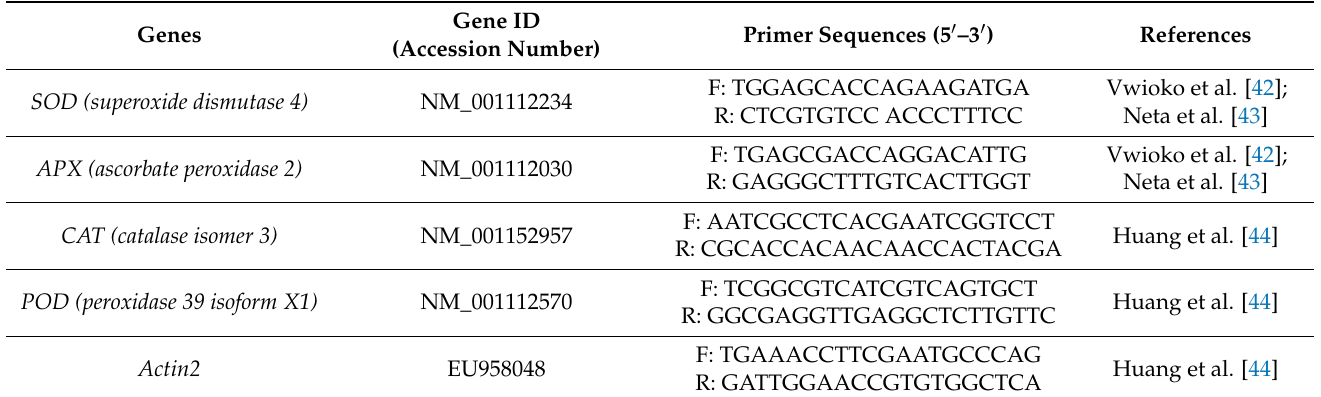
Table 1. Primer sequences for qRT-PCR amplification of antioxidant